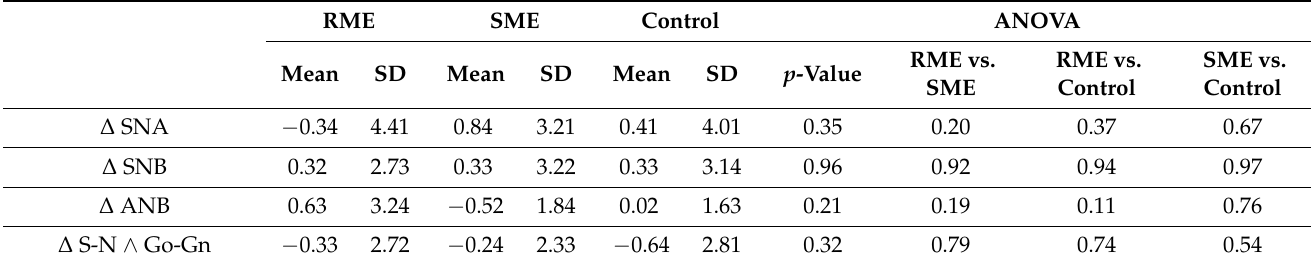
Table 4. Descriptive statistics of the difference between the variables at the two time points in each group and the ANOVA test comparing the values of the three groups and the related pairwise comparisons (Bonferroni’s